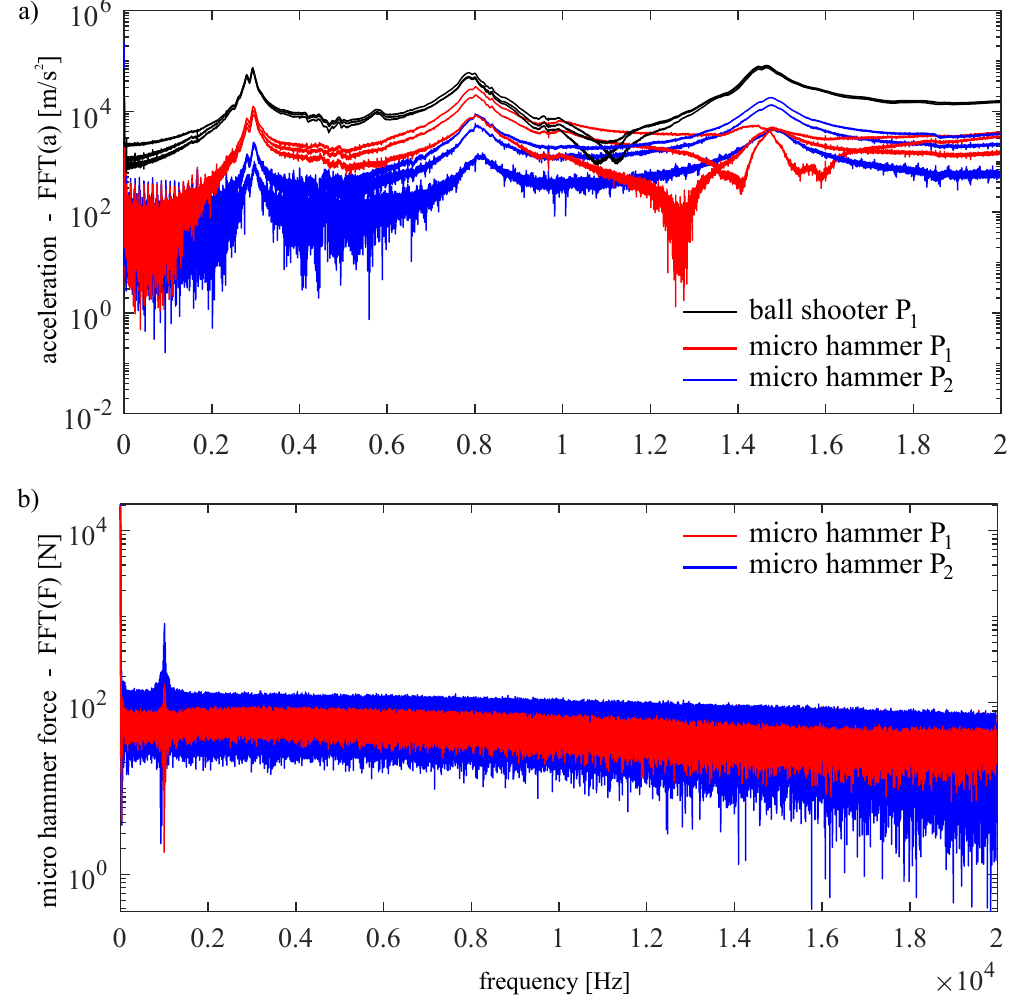
Figure 9. The top panel ( a ) represents the spectrum of the measured acceleration responses induced by the ball shooter at P 1 (black) and the micro hammer at P 1 (red) and P 2 (blue) (three responses for each impulse), while the bottom panel ( b ) presents the spectrum of the applied excitation force by the micro modal hammer at blade height s = 8